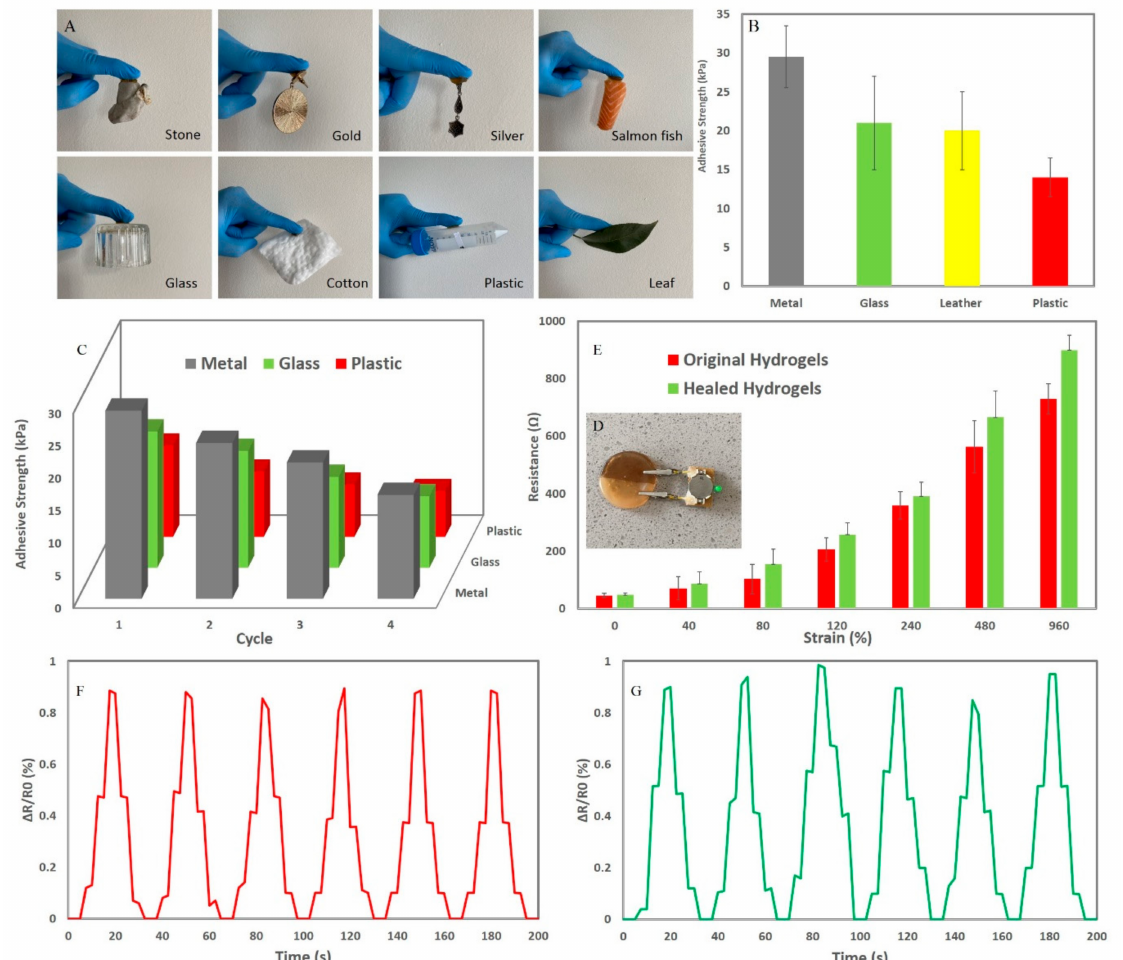
Figure 4. ( A ) Self-adhesiveness of the hydrogel to different substrates, ( B ) measurement of the self-adhesion strength of the hydrogels on different substrates by a tensile test, ( C ) Cyclic self-adhesiveness measurement of the hydrogel on different substrates, ( D ) electroconductivity of the cut hydrogel after healing, ( E ) the resistance of original and healed hydrogel at different strains, and monitoring the relative resistance change of ( F ) original and ( G ) healed hydrogels adhered to the first author’s forefinger to monitor its bending with different angles in